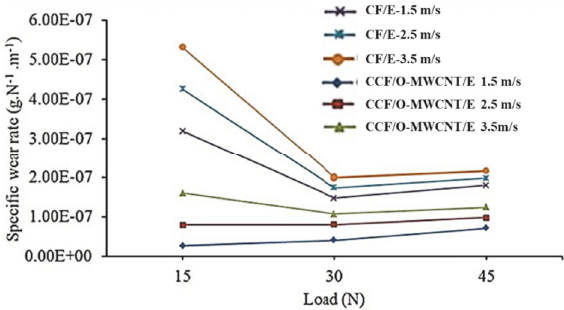
Figure 5: Specific wear rate of CF/E and CCF/O-MWCNT/E com-